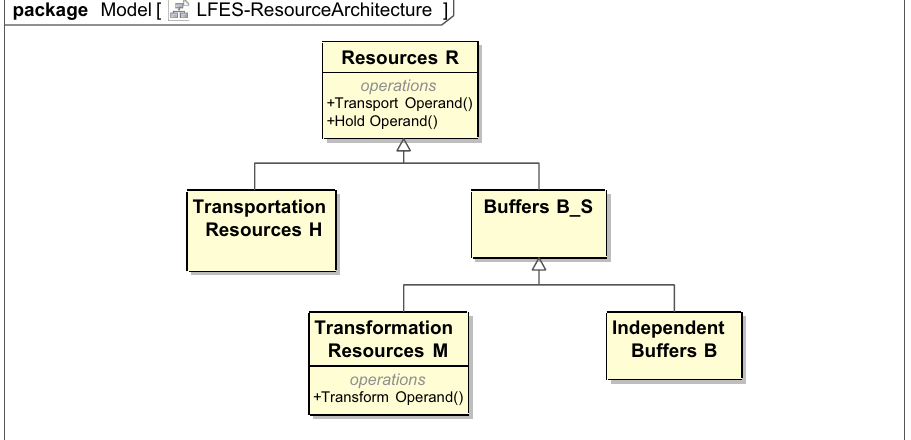
Figure 3. The hetero-functional graph theory meta-architecture drawn using the systems markup language (SysML). It consists of three types of resources R = M ∪ B ∪ H that are capable of two types of process P P P ¯ η = γ × η 7